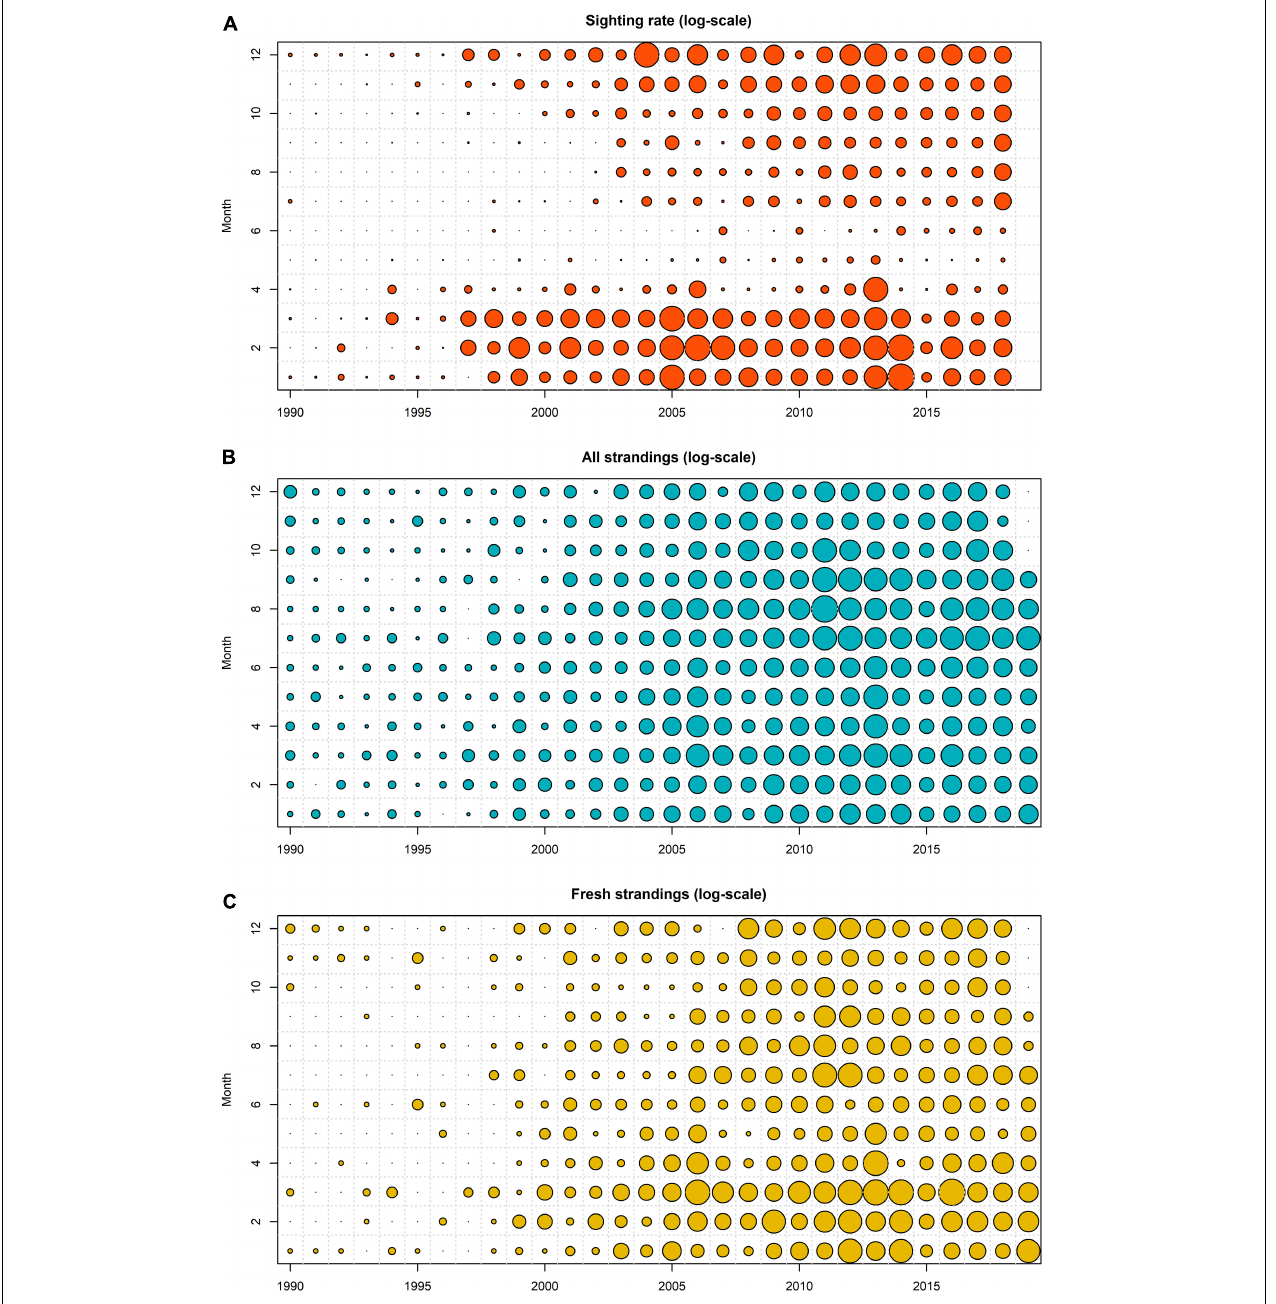
FIGURE 2 | Seasonal and annual patterns in observed sighting rate (A) , all strandings (B) , fresh and alive strandings (C) with the size of the circles representing the respective variables (on the log-scale).